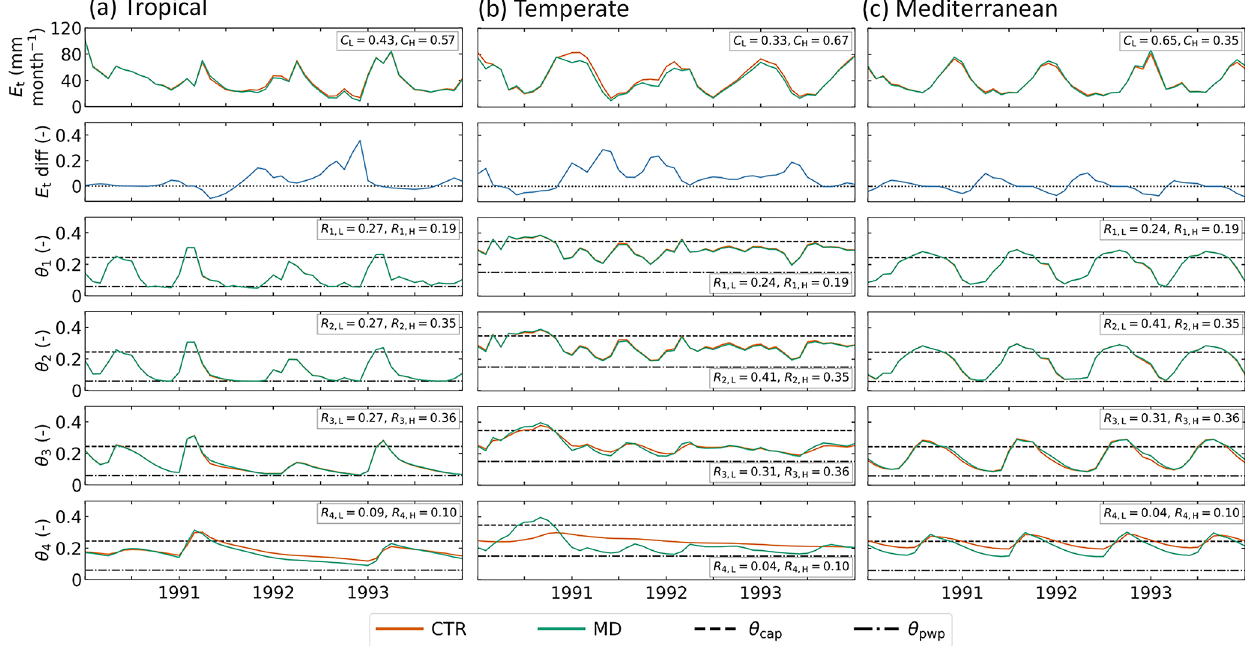
Figure 8. Modeled transpiration and soil moisture content in the HTESSEL CTR and MD versions in an individual representative tropical (catchment Mi) (a) , temperate (catchment Na) (b) and Mediterranean (catchment K) (c) catchment. From top to bottom: transpiration, relative E t,CTR − E t,MD difference between CTR and MD transpiration ( ), soil moisture layer 1, soil moisture layer 2, soil moisture layer 3, soil moisture E t,CTR layer 4. Additionally, the vegetation coverage ( C L and C H ) and the relative rooting distribution ( R k ) for the dominant high and low vegetation types are